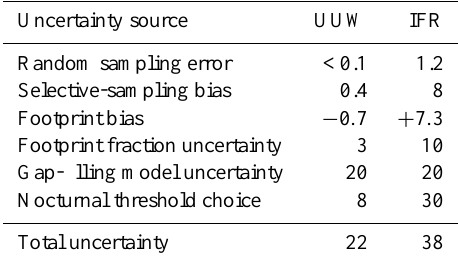
Table 2. Uncertainty estimates (g Cm − 2 yr − 1 ) of net ecosystem production (NEP) for the UUW and IFR pasture. The total uncer- tainty is calculated as the root of the sum of the squares of the listed contributions (excluding footprint